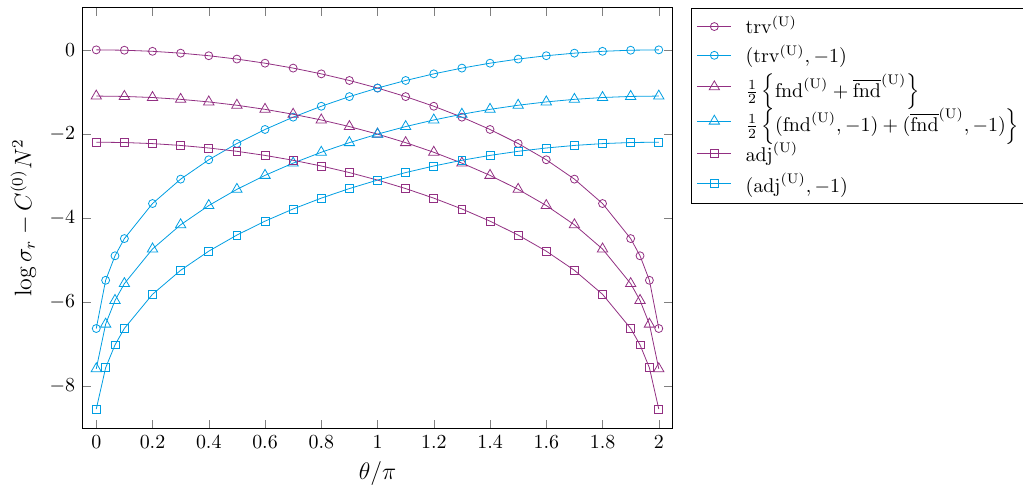
Figure 19 . The quantity (log( σ r ) − C (0) N 2 ) is plotted against θ for trivial, fundamental and adjoint representations in the U( N ) gauge theory with N = 20 at λ = 3 . We also plot the results for representations with charge q = − 1 with blue